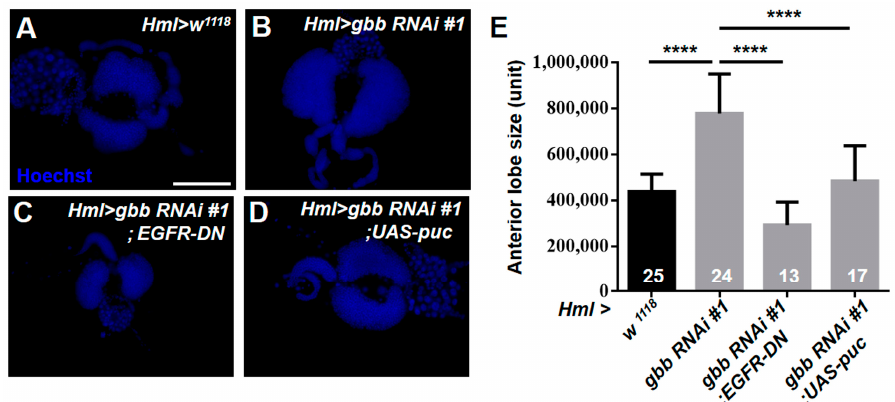
Figure 7. Inactivation of the EGFR or JNK pathway dramatically reduced the overgrowth of the anterior lobes in the Hml > gbb RNAi#1 lymph glands. ( A – D ) Immunostaining of the lymph gland with Hoechst showed that the enlargement of the anterior lobes of Hml > gbb RNAi#1 lymph glands was obviously rescued by the inactivation of EGFR and JNK pathways. ( E ) Quantification of anterior lobe size. For all quantifications: *** p <0.001 (Student’s t test). Scale bars: 100 μ m ( A – D ).